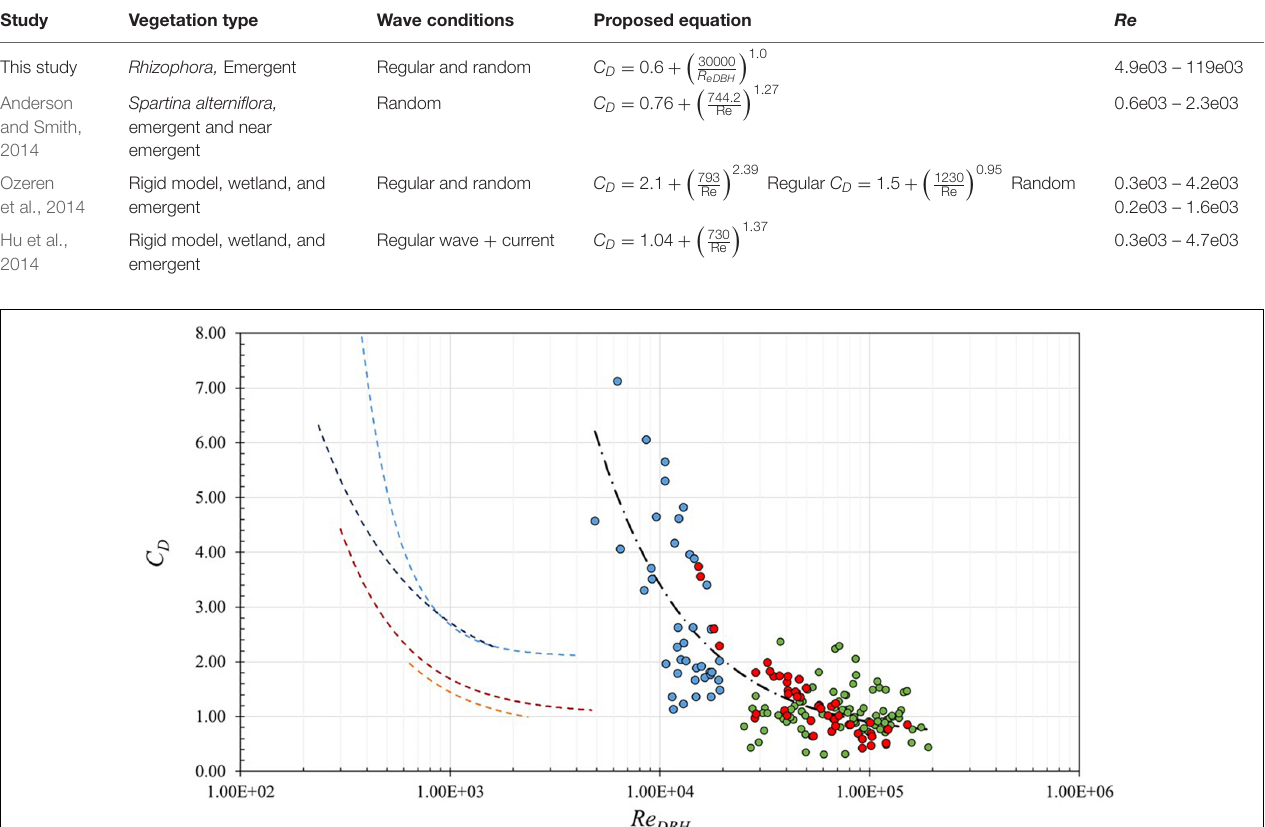
FIGURE 11 | Drag coefficient C D vs. Reynolds number Re DBH on logarithmic scale for comparison of previous studies of emergent wetland vegetation (dashed lines): Anderson and Smith (2014) (random waves, orange), Hu et al. (2014) (regular waves + current, red), Ozeren et al. (2014) (regular and random waves, light and dark blue, respectively) to the proposed equations for the combined mangrove data (black dash-dot line) of present study (red circles), Chang et al. (2019) (blue circles), and Maza et al. (2019) (green circles). Note x- axis origin is at